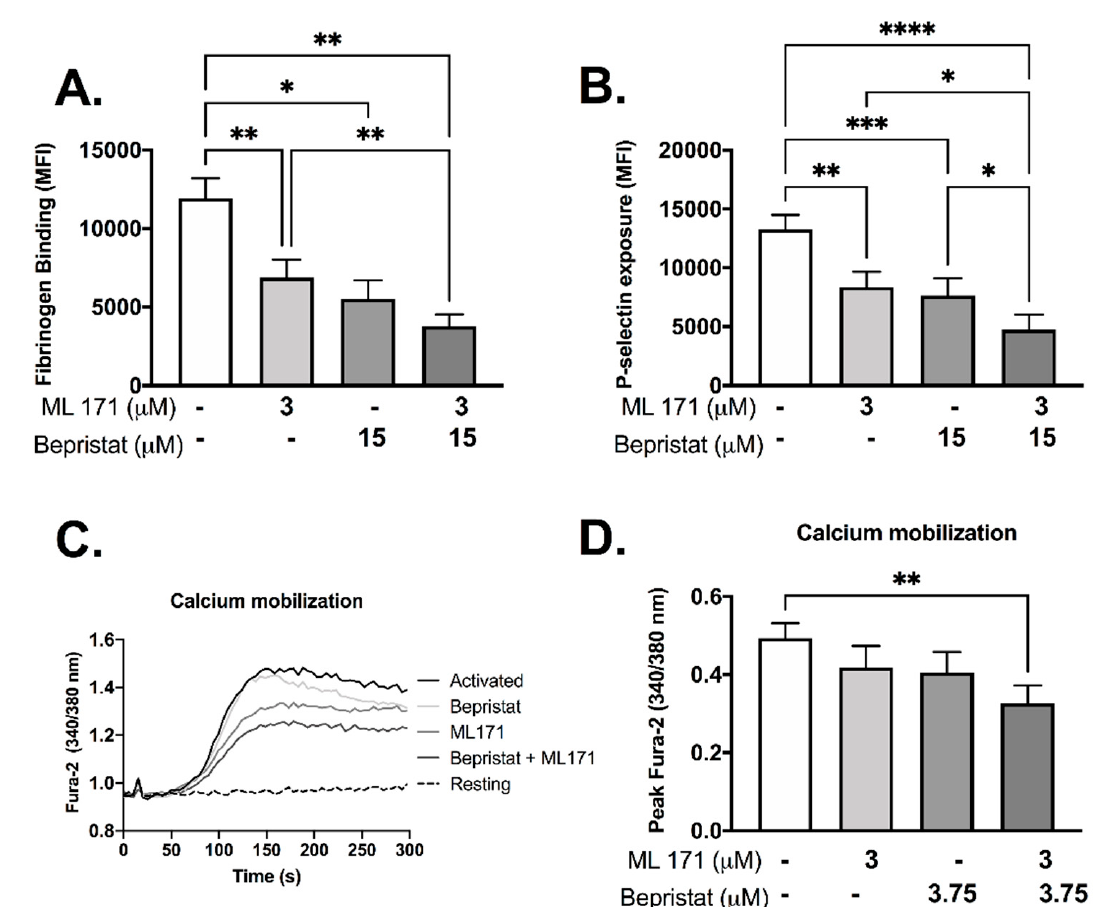
Figure 3. Bepristat and ML171 display additive inhibitory effects on CRP-induced fibrinogen binding, P-selectin exposure and calcium mobilization. ( A , B ): Human WP (4 × 10 7 platelets/mL) were incubated with 3 µ M ML171 and/or 15 µ M bepristat for 10 min, then 1 µ g/mL CRP was added. FITC-fibrinogen and PE/Cy5-anti-P-selectin were incubated for 30 min and events acquired using a flow cytometer. Data expressed as median fluorescence intensity (MFI). ( C ): Representative curve of WP pre-incubated with calcium dye Fura-2 AM and pre-treated with 3 µ M ML171 and/or 3.75 µ M bepristat for 10 min prior to activation with 1 µ g/mL CRP. Fluorescence acquired over 5 min using a plate reader. ( D ) Summary statistics for data in ( C ) activated with CRP. Peak Fura-2 was determined as the highest fluorescence value subtracted from baseline before agonist addition. n = 6 for ( A , B ), while n = 4 for ( C , D ). Bar graphs show mean ± SEM. Data analysed by paired one-way ANOVA and Tukey’s post-test. * p < 0.05, ** p < 0.01, *** p < 0.001 and **** p < 0.0001.